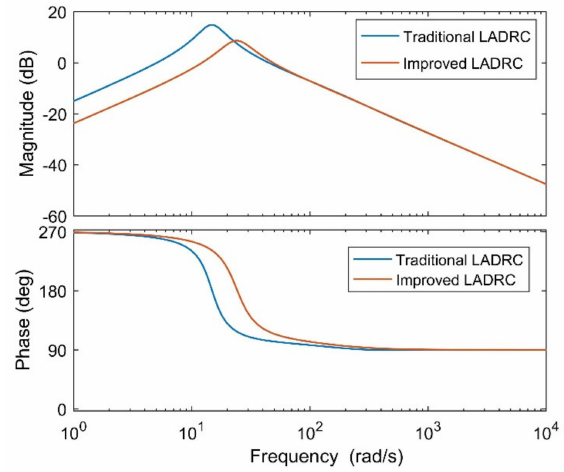
Figure 13. Frequency domain characteristics of improved LADRC and traditional